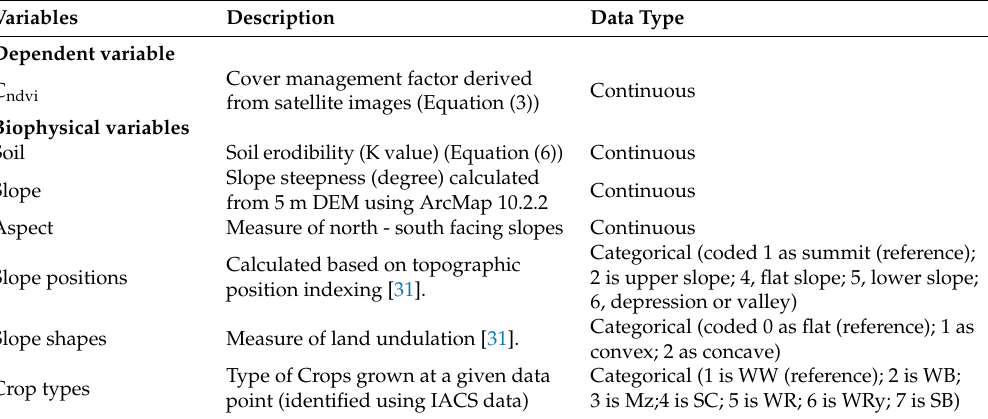
Table 3. Description of explanatory variables used for regression analysis to investigate the influence of spatiotemporal and crop type variations on C ndvi